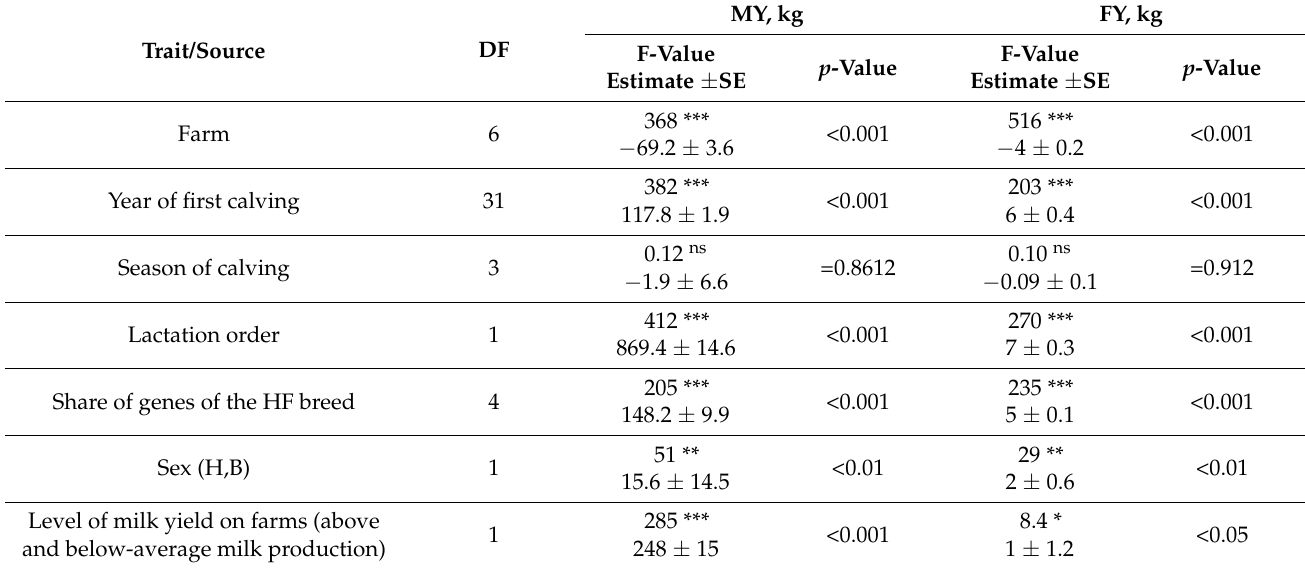
Table 4. Statistical significance of effects (F, estimate ± SE and p values) on milk yield (MY) and fat yield (FY).